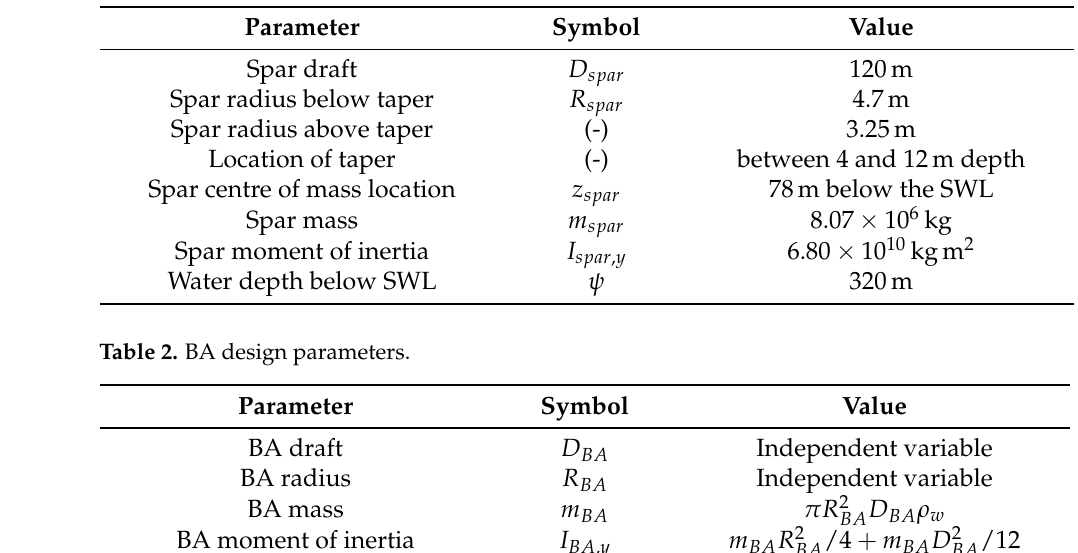
Table 1. Spar design parameters.